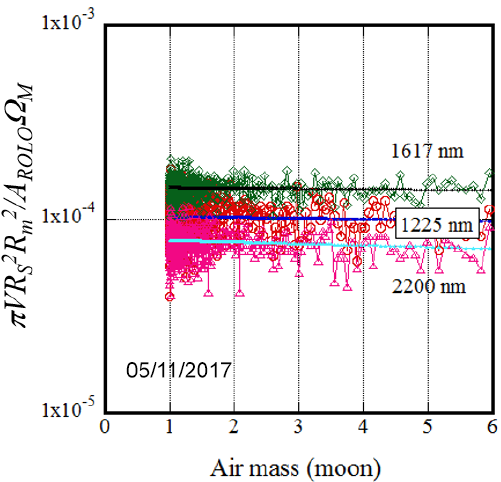
Figure 4. Examples of the Langley plot in the shortwave infrared